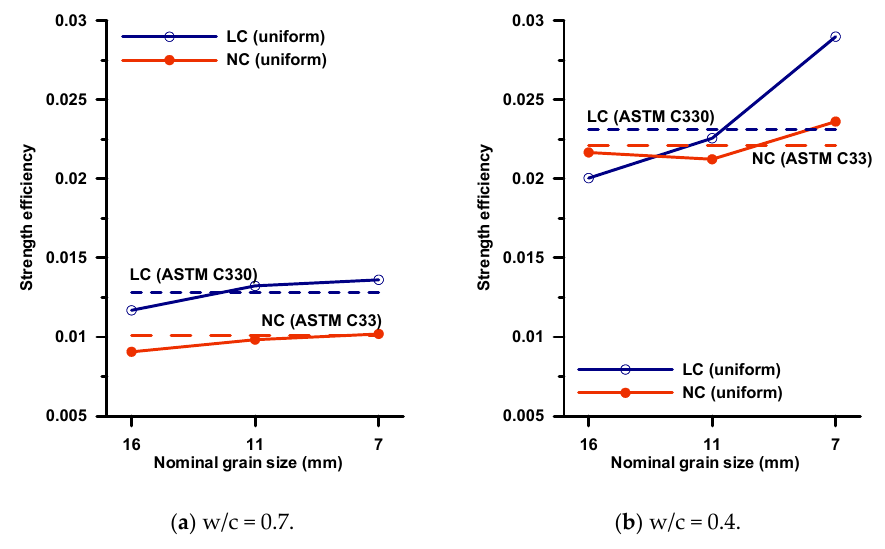
Figure 7. Strength efficiency of NWC and LWAC.